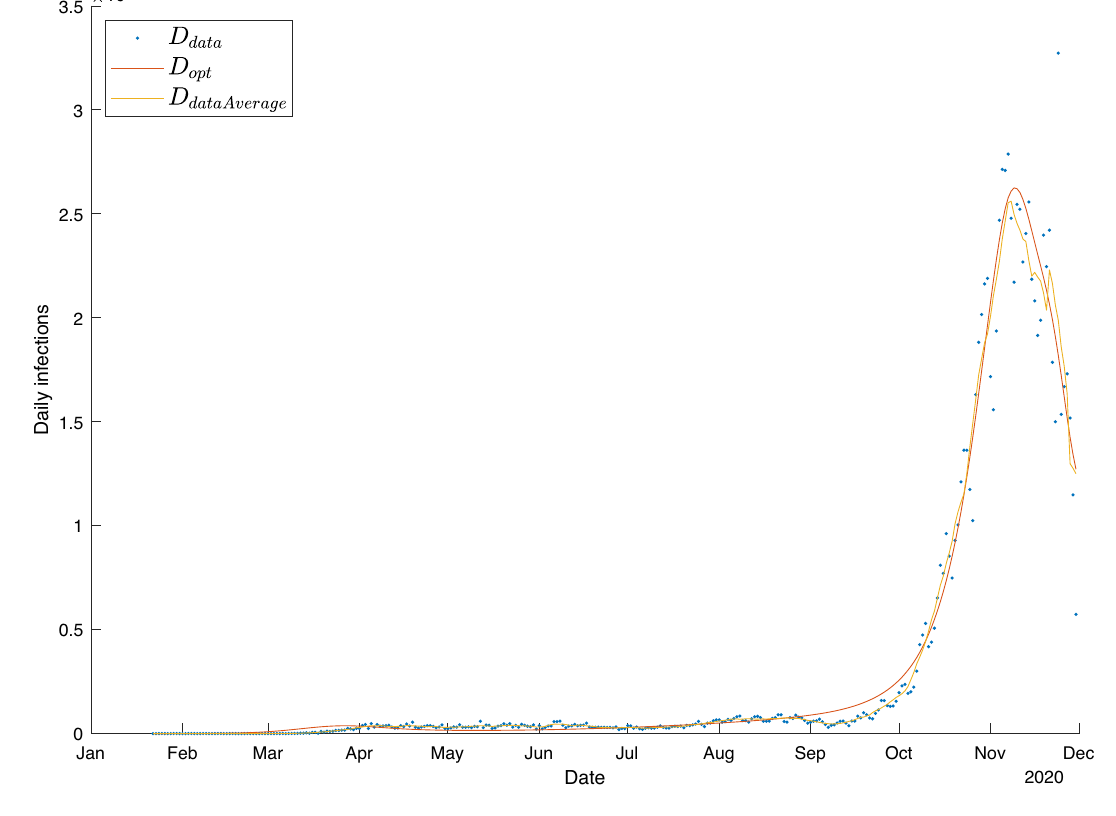
Figure 5. Example fit (Poland) based on β opt over the training time period. Blue points represent daily infections, the yellow line the seven-day moving average of daily infections, and the red line is the fit obtained by substituting the β opt ( t ) into the SEIR model. The red and yellow lines practically overlap.